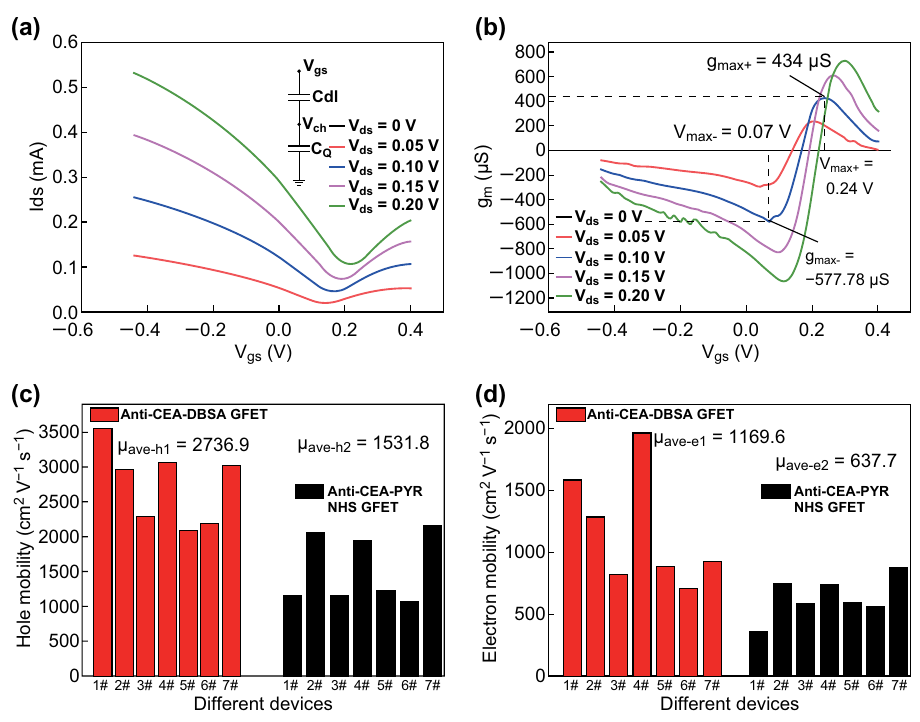
Fig. 3 a Transfer characteristics of the anti‑CEA‑dBSA functionalized GFET. The insert in a is the capacitive equivalent circuit model of the graphene conducting channel. b Anti‑CEA‑dBSA functionalized GFET at different drain–source voltages was defined as the derivative of Ids with respect to V gs . c Hole mobility of anti‑CEA‑dBSA functionalized GFET and anti‑CEA mAb PYR‑NHS functionalized GFET. d Electron mobility of anti‑CEA‑DBSA functionalized GFET and anti‑CEA mAb PYR‑NHS functionalized